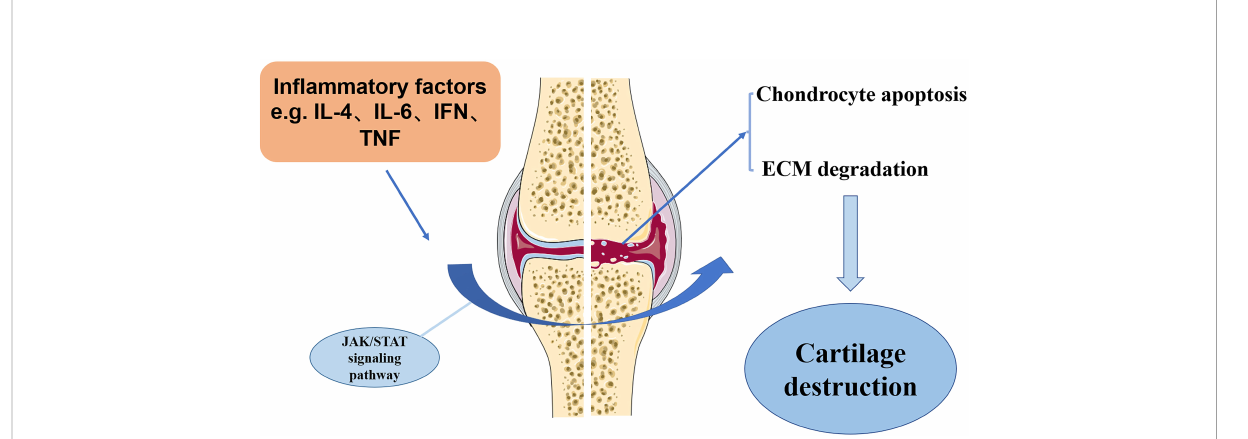
FIGURE 3 The potential mechanism of JAK/STAT pathway in OA development. In fl ammation factors, such as IL-6, IL-4, and TNF a , in the OA cartilage can stimulate JAK/STAT pathway, which induces the destruction of OA cartilage, as shown by increased chondrocyte apoptosis and ECM